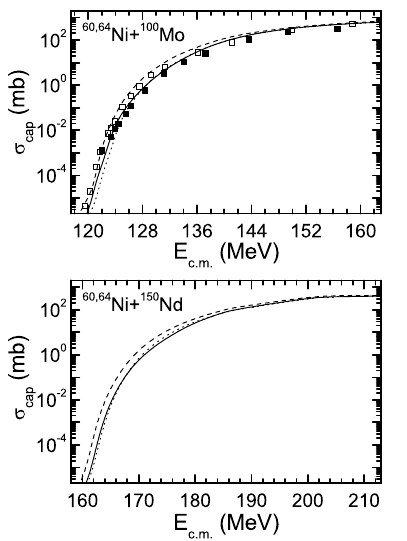
Figure 6. (Color online) The same as in Fig. 1, for the indicated reactions 60 Ni + 100 Mo, 150 Nd (solid lines), and 64 Ni + 100 Mo, 150 Nd (dashed lines). For the reactions 60 Ni + 100 Mo and 60 Ni + 150 Nd, the calculated capture cross sections without the neutron transfer are shown by dotted lines. The experimental data for the reactions 60 Ni + 100 Mo (closed squares) and 64 Ni + 100 Mo (open squares) are from Ref.